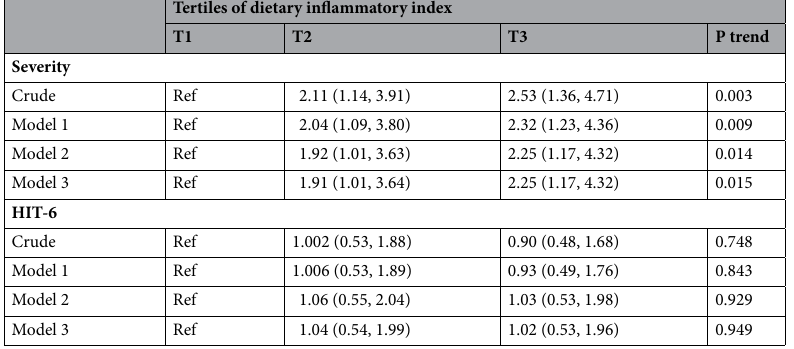
Table 4. Odds ratio (OR) and 95% confidence interval for headache severity and HIT-6 across tertiles of the dietary inflammatory index. Data are presented as odds ratio (95% confidence interval) and obtained from logistic regression. Crude: Unadjusted. Model 1: Adjusted for age and sex. Model 2: Model 1 + marital status, smoking status, migraine characteristic, family history, mean arterial pressure, and physical activity. Model